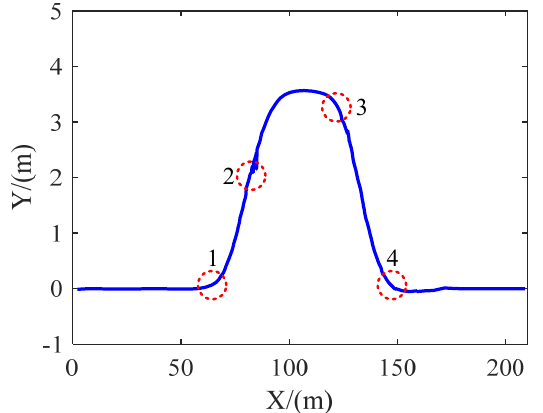
Figure 4. Routing and point selection in double lane change. (The red dotted circles are randomly selected four points) .